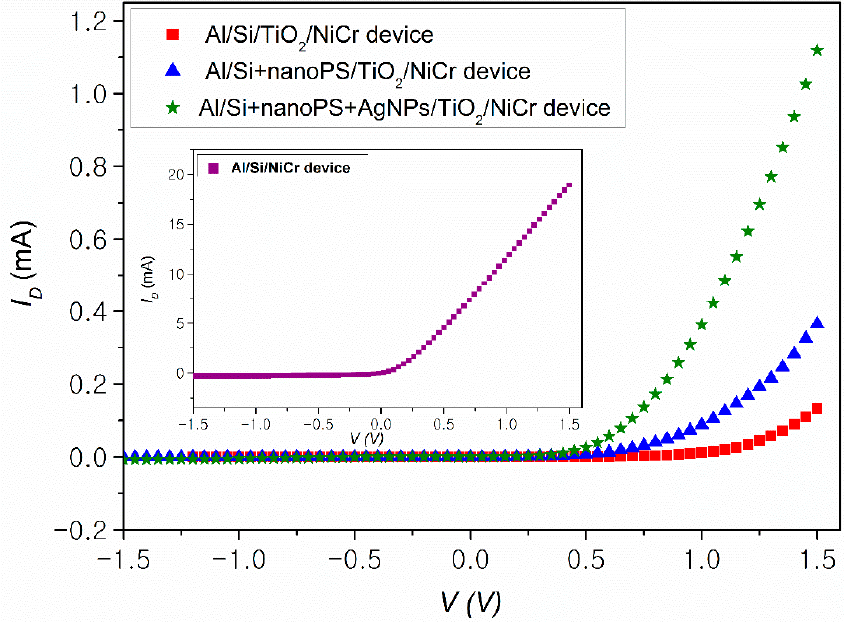
Figure 9. Current ‐ voltage ( I ‐ V) curve for the three MIS Schottky junction devices under forward